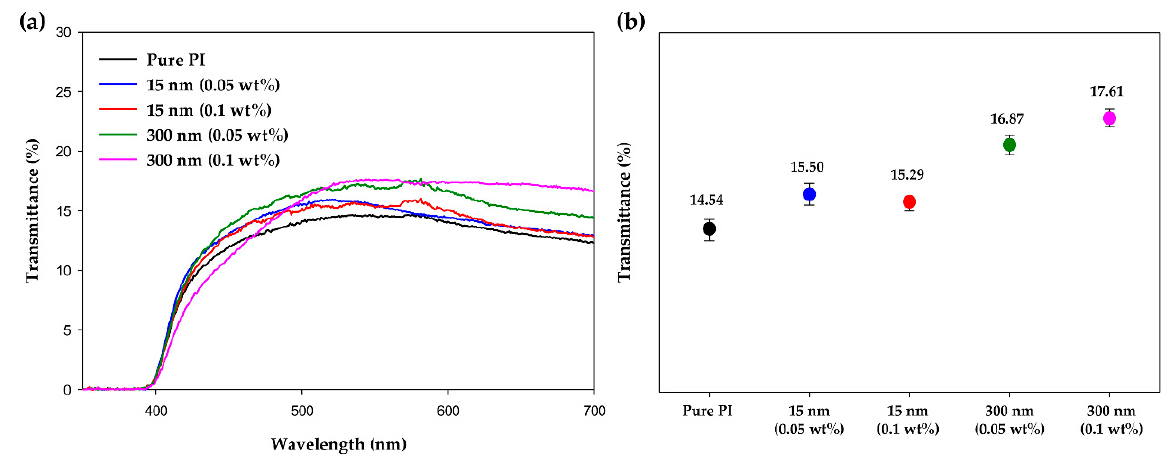
Figure 6. ( a ) UV–vis spectra and ( b ) optical transmittances of the pure polyimide LC cell and LC cells fabricated using hybrid polyimide alignment layer.